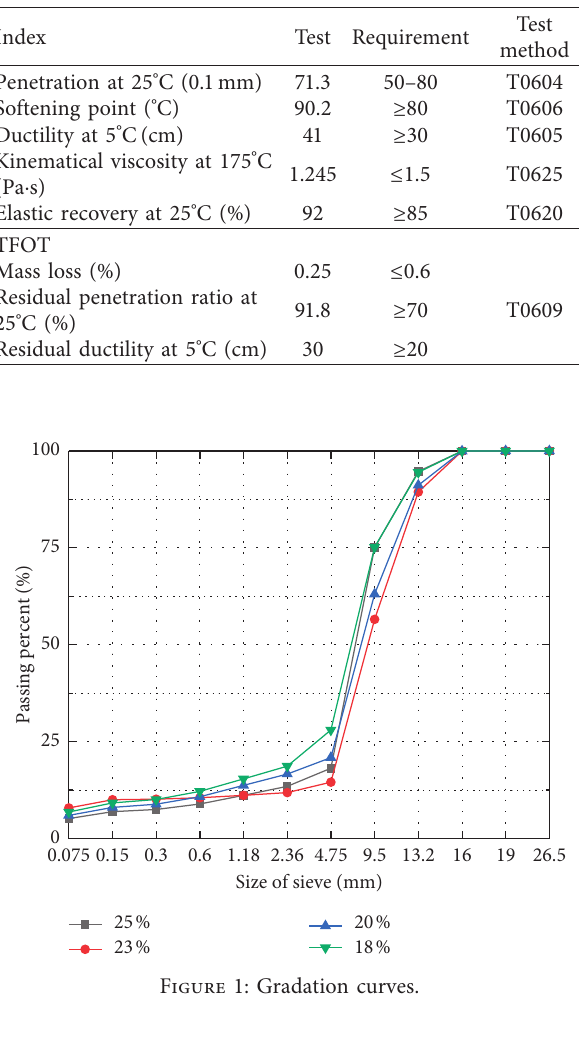
Table 1: Properties of modified asphalt